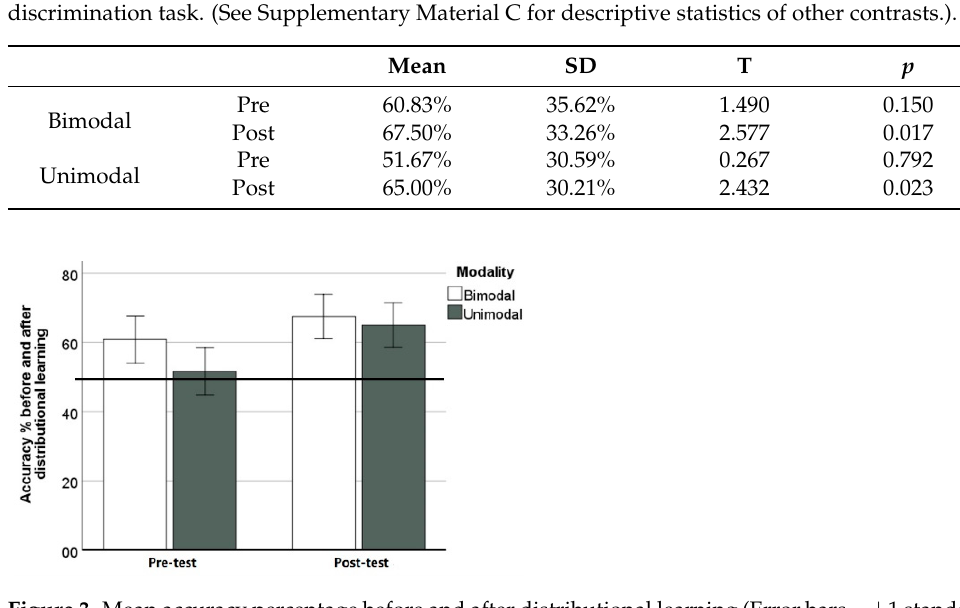
Figure 3. Mean accuracy percentage before and after distributional learning (Error bars = ±1 standard error). The horizontal line indicates chance level (50%) performance.